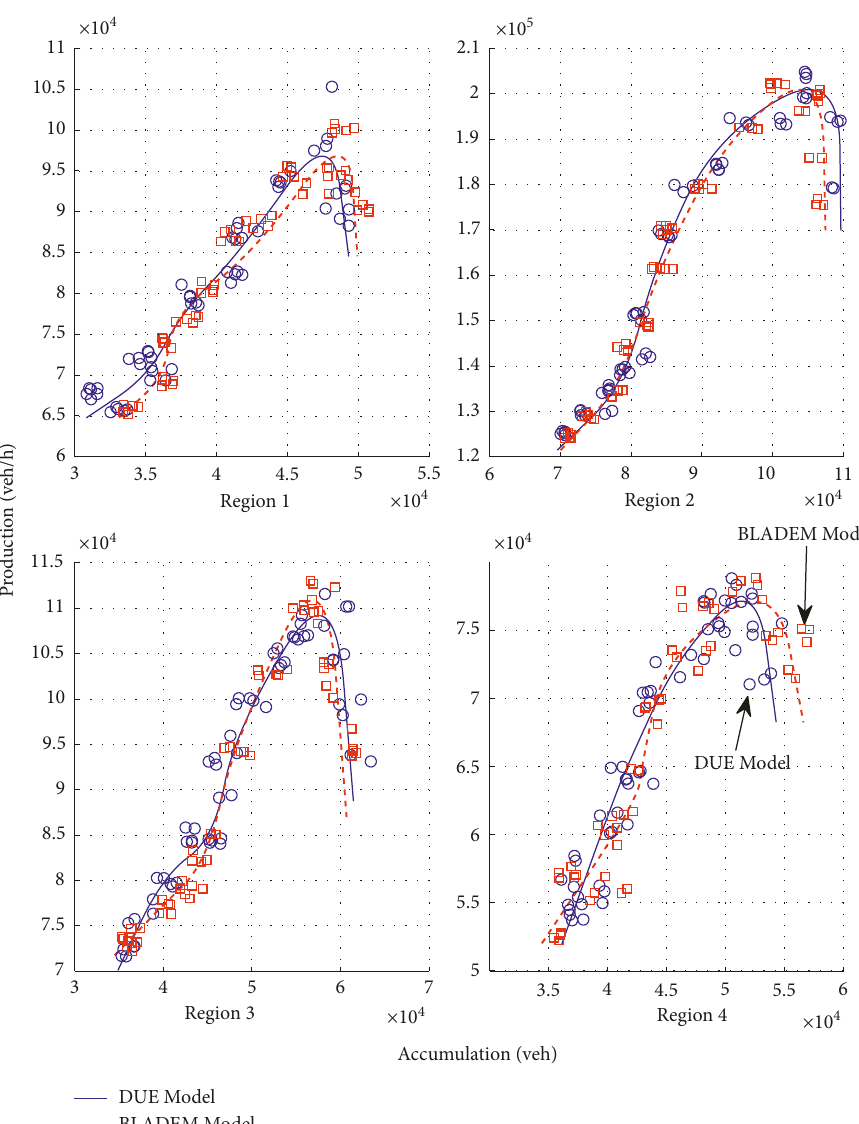
Figure 7: Consistency validation of dynamic characteristics in